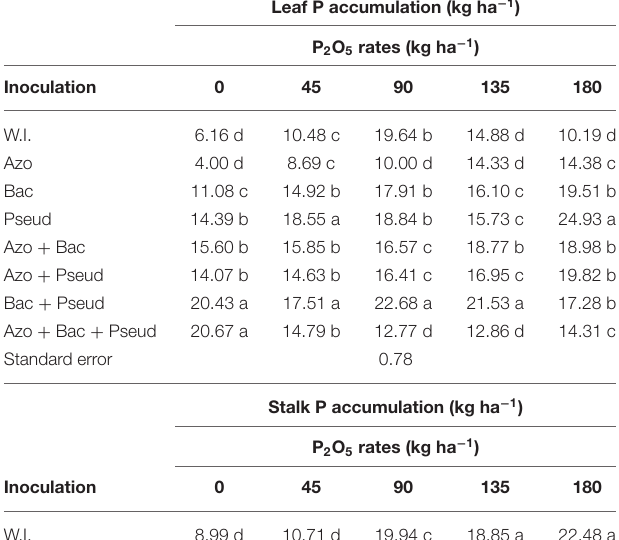
TABLE 8 | Interactions between bacterial inoculations and P 2 O 5 doses for leaf P TABLE 7 | Phosphorus (P) accumulation in leaf, stalk, and total plant as accumulation, stalk P accumulation and total P accumulation in sugarcane crop. influenced by different bacterial inoculations and P 2 O 5 doses in sugarcane crop. Leaf P Stalk P Total P accumulation accumulation accumulation kg ha − 1